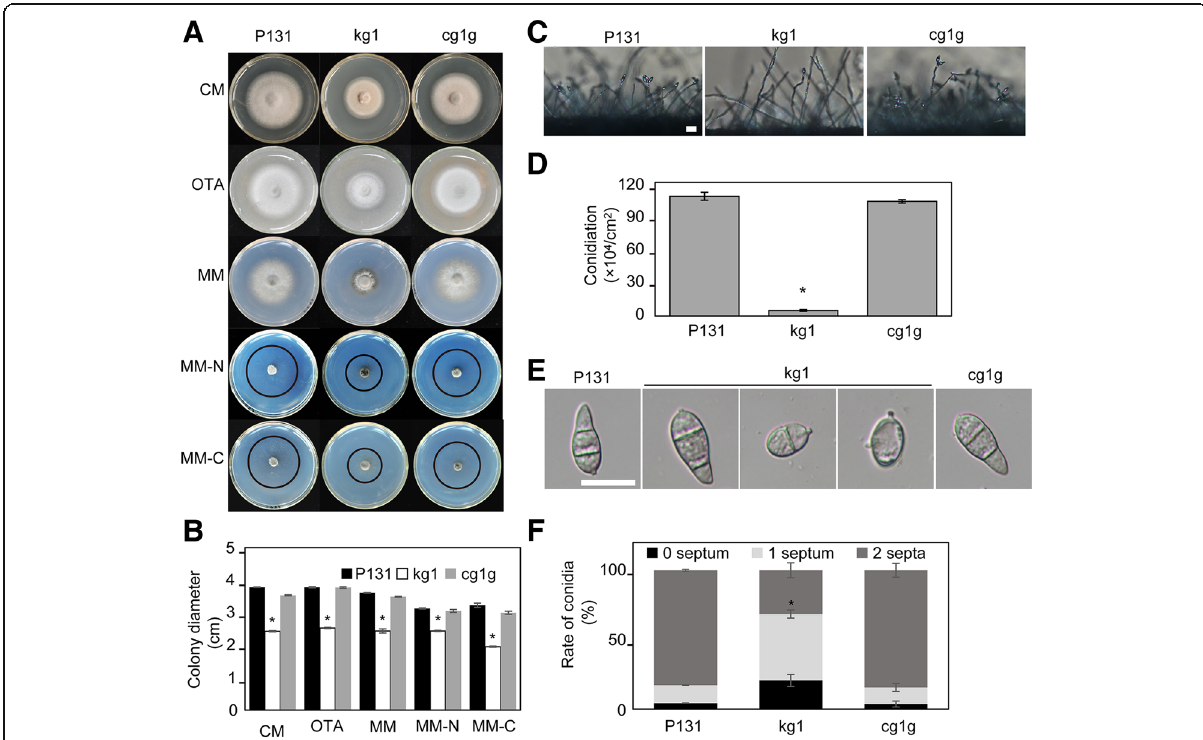
Fig. 2 MoGRP1 is indispensable for hyphal growth, stress responses, and conidiation. a Mycelial growth of the wild-type strain P131, the Δ Mogrp1 mutant kg1, and one Δ Mogrp1 complementation transformant cg1g on CM, OTA, MM, MM-C, and MM-N plates at 28 °C for 5 days. The black circle indicates the extent of mycelia grown on MM-N and MM-C plates; b Column diagram showing colony diameter of strains cultured on different media in ( a ). The mean ± SD was calculated based on three independent experiments measuring three plates in each replicate. An asterisk marks significant differences among strains according to a T-test ( P < 0.05); c Conidiation structures of strains P131, kg1, and cg1g cultured on OTA plates. Bar, 30 μ m; d Conidiation capacity of strains P131, kg1, and cg1g cultured on OTA plates. The mean±SD was calculated based on three independent experiments measuring three plates in each replicate. * P < 0.05; e Conidial morphology of strains P131, kg1, and cg1g. Bar, 20 μ m; f Percentage of conidia with 0-, 1-, and 2- septa of strains P131, kg1, and cg1g. The mean ± SD was calculated based on three independent experiments measuring at least 100 conidia in each replicate. * P < 0.05